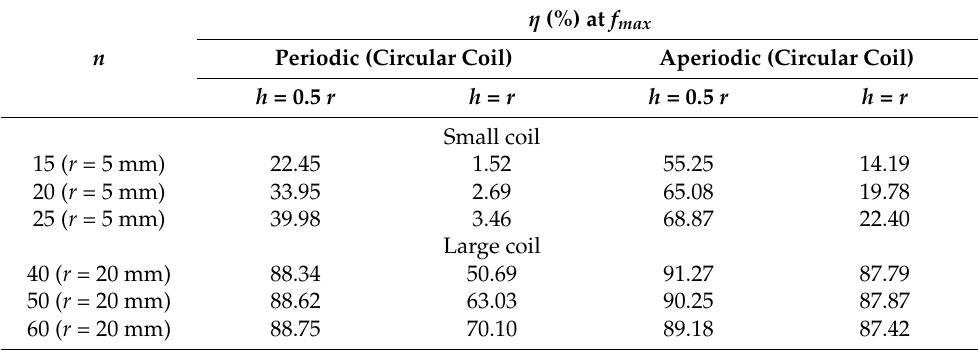
Table 5. The values of the power transfer efficiency at f max = 1 MHz for a circular coil (periodic and aperiodic).